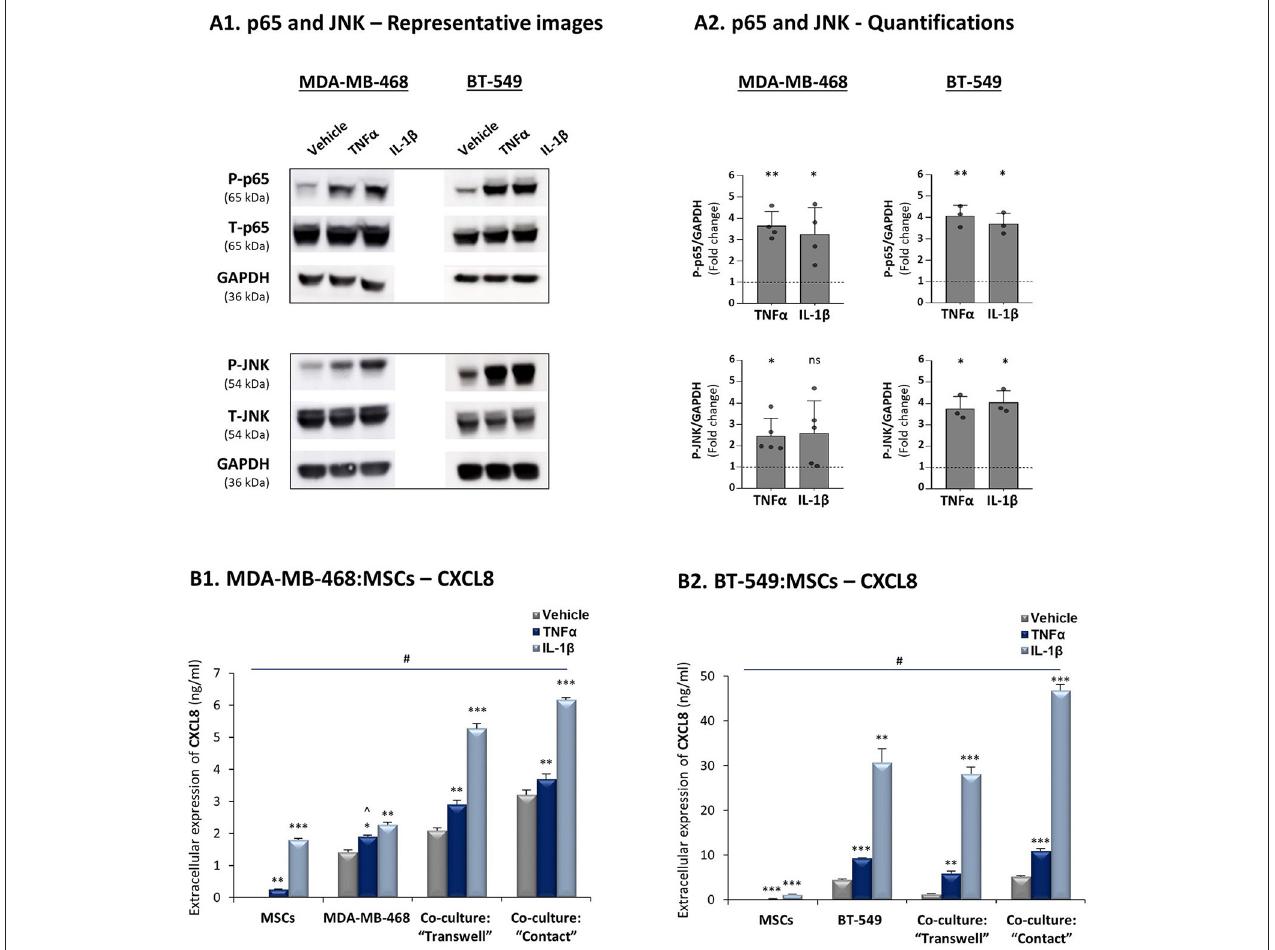
FIGURE 5 | Increased production of CXCL8 is a general characteristic of tumor-stroma-inflammation networks established with TNBC cells. The Figure demonstrates similar experiments and statistical analyses as those of Figure 3 , performed herein with human TNBC MDA-MB-468, BT-549 cells and MSCs. Cytokine concentrations: MDA-MB-468 cells - 50ng/ml TNF α and 500 pg/ml IL-1 β ; BT-549 cells - 25ng/ml TNF α and 350 pg/ml IL-1 β . (A) Activation of p65 and JNK. (B) CXCL8 expression levels. In all parts of the Figure, the results are of a representative experiment of n ≥ 3 independent experiments, performed with MSCs of 2 different donors. ∧ In panel 5B1, this value was significant in 2 out of 3 experiments. *,**,***, # - As described in Figure 3 . ns=non-significant. (2) elevated angiogenesis, tumor cell migration and